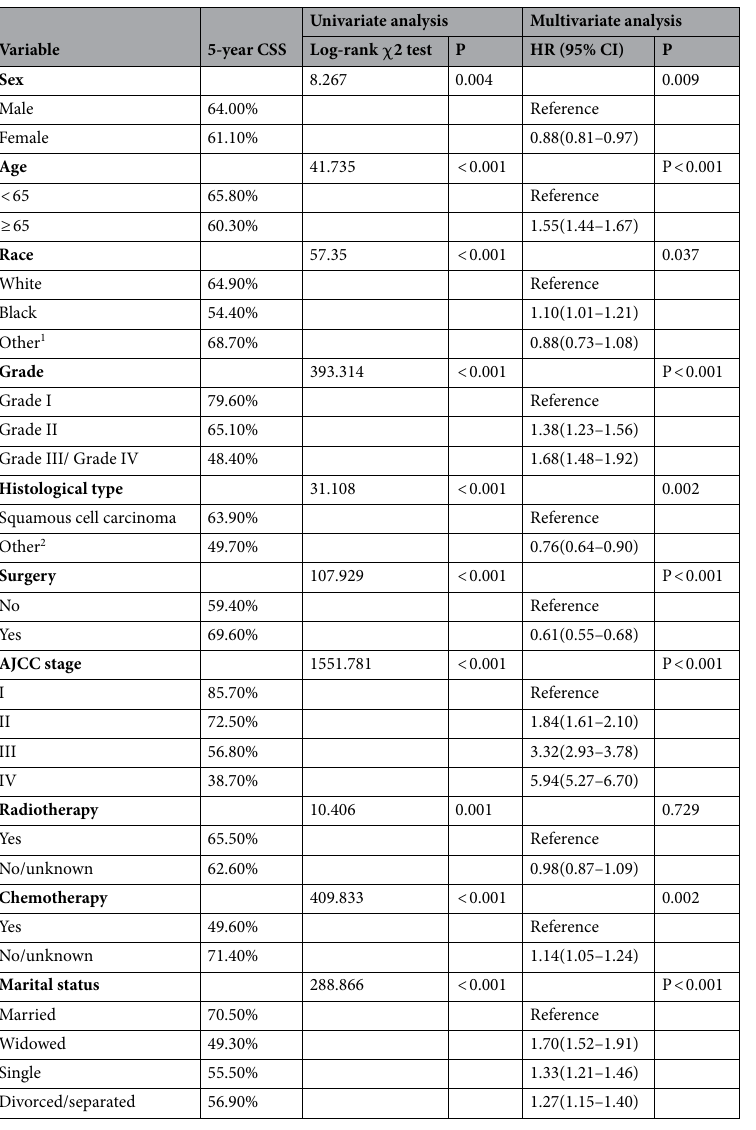
Table 3. Univariate and multivariate survival analysis of CSS in laryngeal cancer patients before PSM. Other 1 (Asian or Pacific Islander, American Indian/Alaska Native). Other 2 (Neoplasm, malignant; Carcinoma, NOS; Carcinoma, undifferentiated, NOS; Large cell carcinoma, NOS; Large cell neuroendocrine carcinoma; Spindle cell carcinoma, NOS; Pseudosarcomatous carcinoma; Carcinoma, anaplastic, NOS; Non-small cell carcinoma; Small cell carcinoma, NOS; Papillary squamous cell carcinoma; Verrucous carcinoma, NOS; Combined small cell carcinoma; Papillary carcinoma, NOS; Basaloid squamous cell carcinoma; Lymphoepithelial carcinoma; Basaloid carcinoma; Adenocarcinoma, NOS; Scirrhous adenocarcinoma; Adenoid cystic carcinoma; Neuroendocrine carcinoma, NOS; Mucoepidermoid carcinoma; Papillary carcinoma, follicular variant; Adenosquamous carcinoma; Adenocarcinoma with cartilaginous and osseous metaplasia; Adenocarcinoma with neuroendocrine differentiation; Carcinoma in pleomorphic adenoma). CSS, cancer-specific survival; PSM, propensity score matching; HR, hazard ratio; CI, confidence